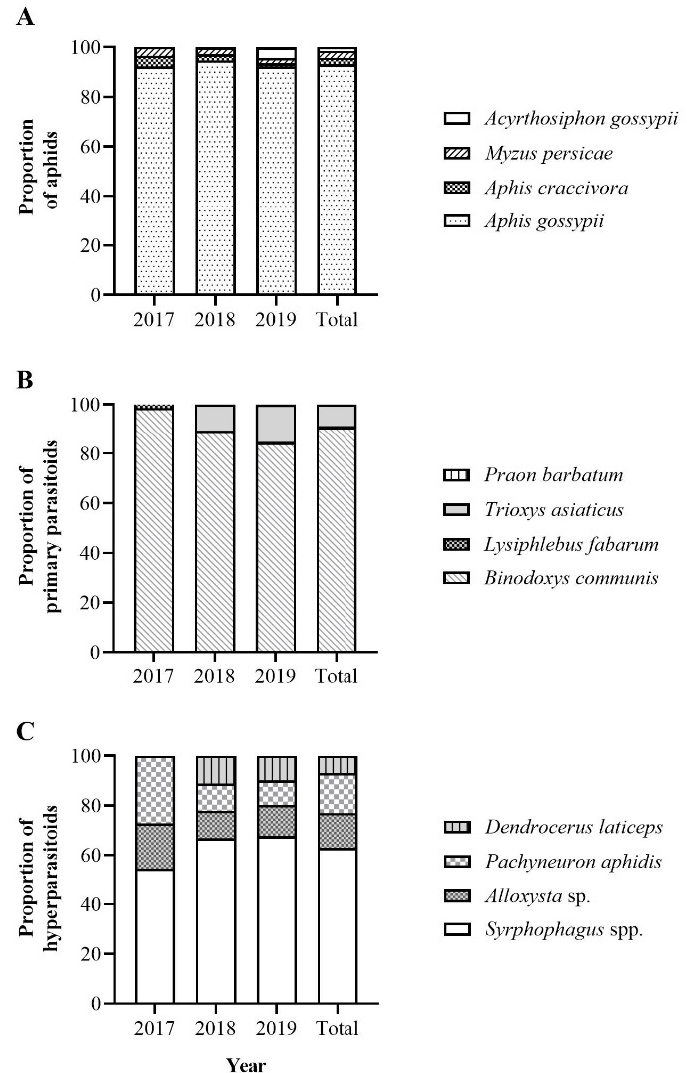
Figure 3. The proportion of aphids ( A ), primary parasitoids ( B ) and hyperparasitoids ( C ) consumed by Hippodamia variegata over 2017–2019.